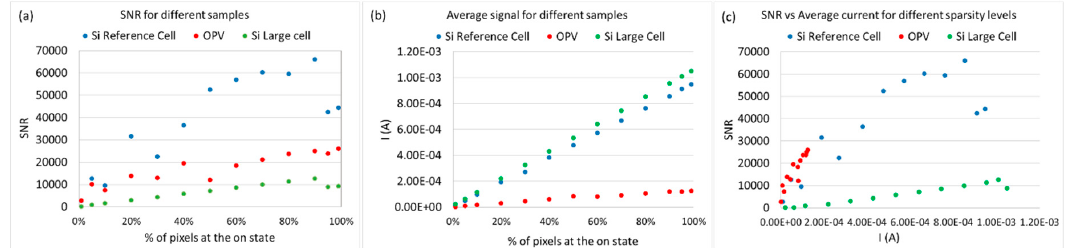
Figure 6. ( a ) Measurement SNR for the three different samples in the case of compressive sampling, with reducing levels of sensing matrix sparsity. ( b ) Signal amplitude (current reading) for the three different samples in the case of compressive sampling, with reducing levels of sensing matrix sparsity. ( c ) SNR as a function of average current of samples, while reducing sparsity levels.